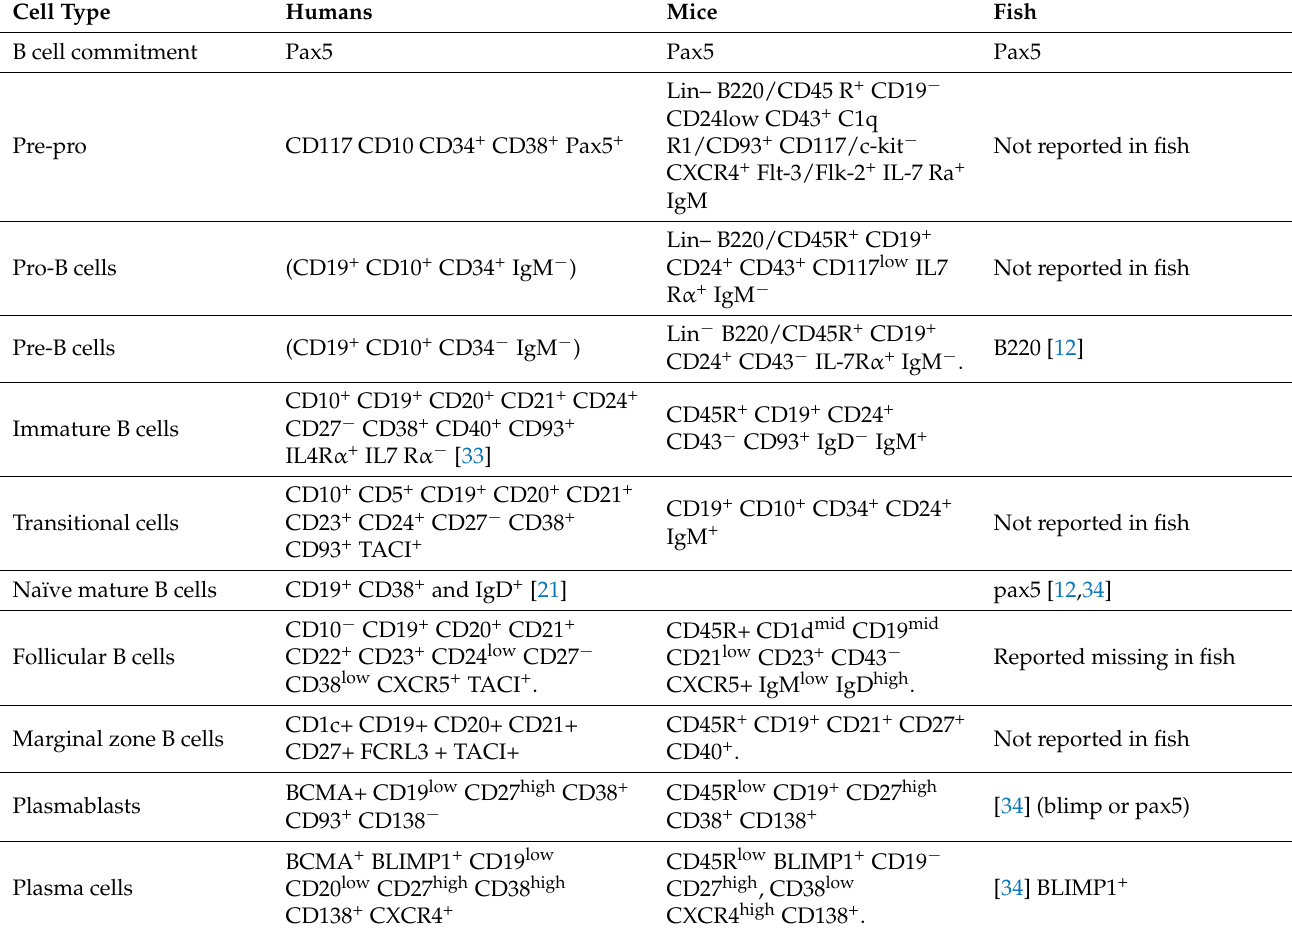
Table 1. Various B cells in comparison with literature findings in